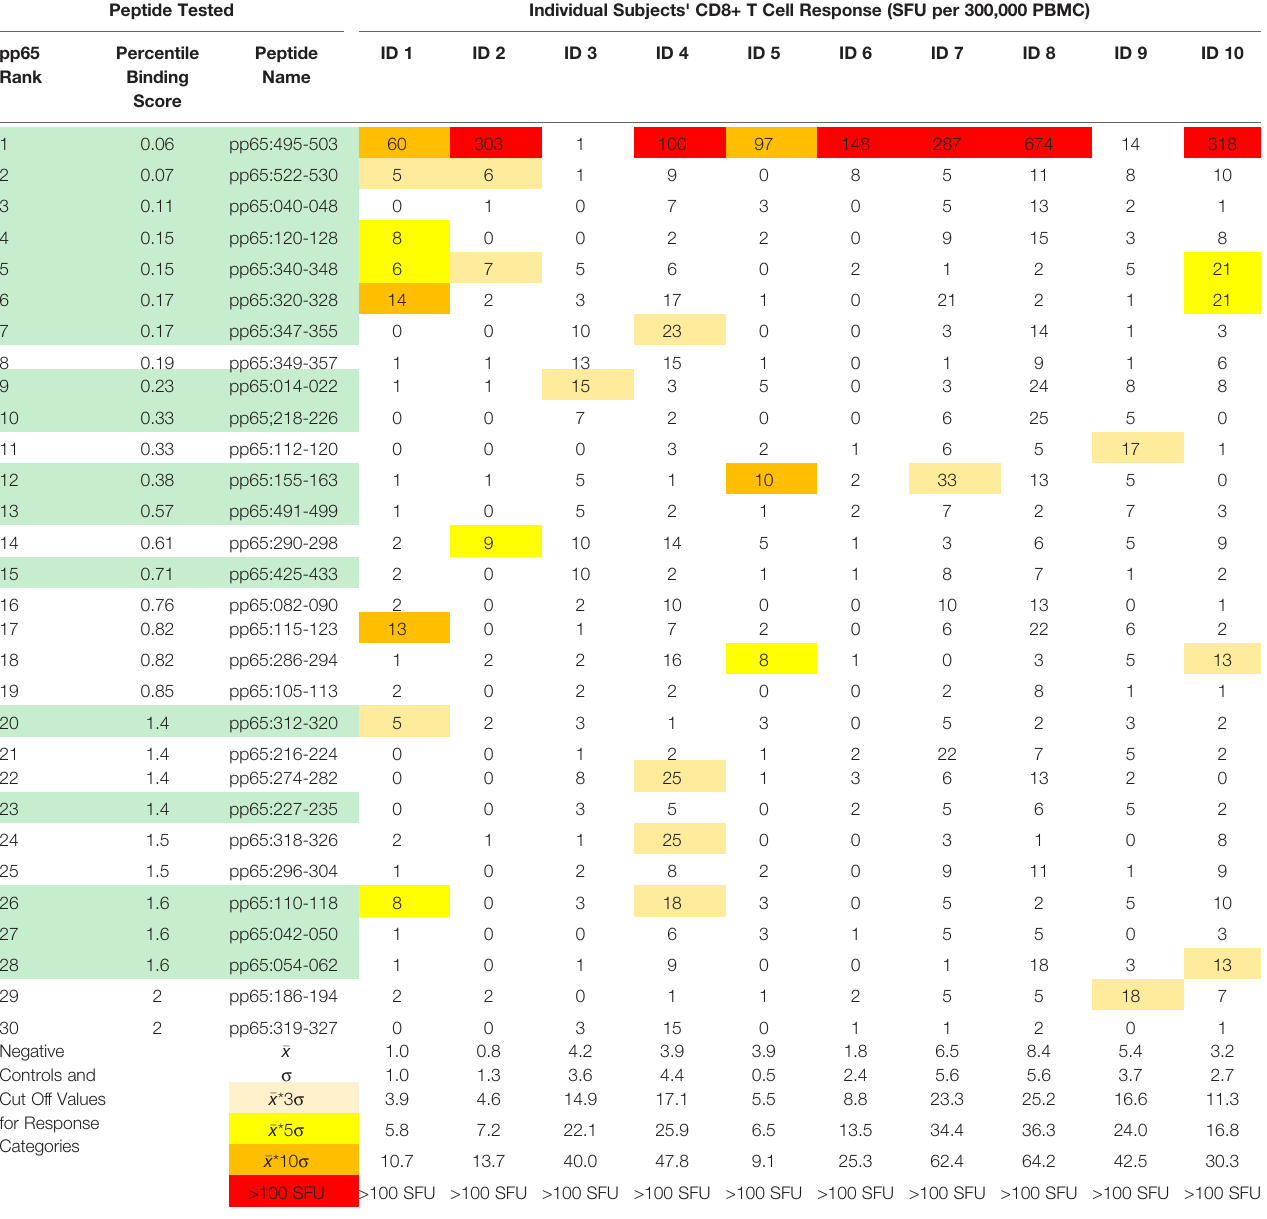
TABLE 3 | CD8+ T cell recognition of predicted high HLA-A*02:01 -binding peptides. Peptide